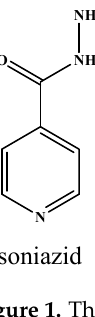
Figure 1. The structures of isoniazid and ethionamide.